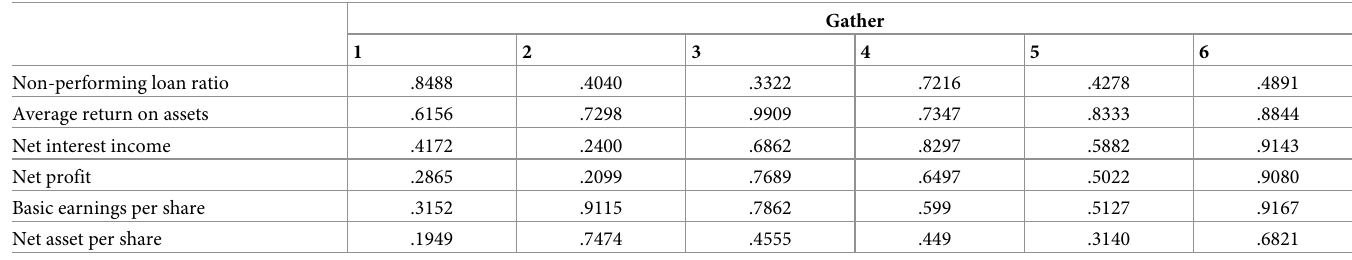
Table 2. Final aggregation